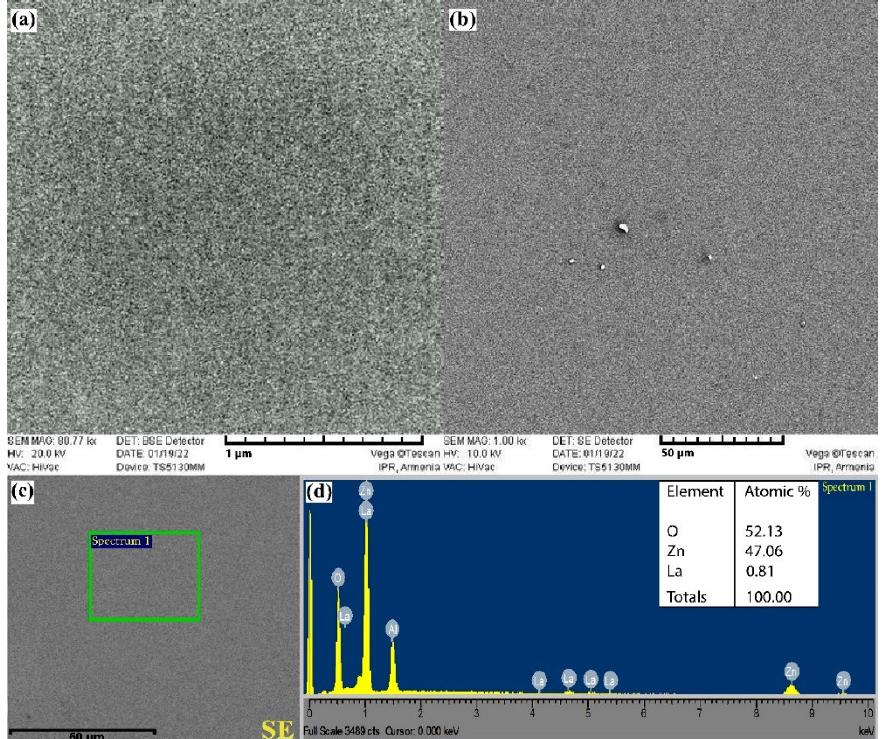
Figure 7. ( a , b ) SEM images, ( c ) SEM SE plane-view and ( d ) EDX spectrum of the ZnO<La> film. Elemental mapping analysis of the ZnO<La> film was carried out by EDX spectros- copy. The SEM image, the corresponding results of elemental mapping analysis of the ZnO<La> film, and the X-ray intensity of characteristic lines of different elements are pre- sented in Figure 8. It is obvious that the distribution of elements Zn, Al, O, and La is even, differed from each other by colors in the mapping.